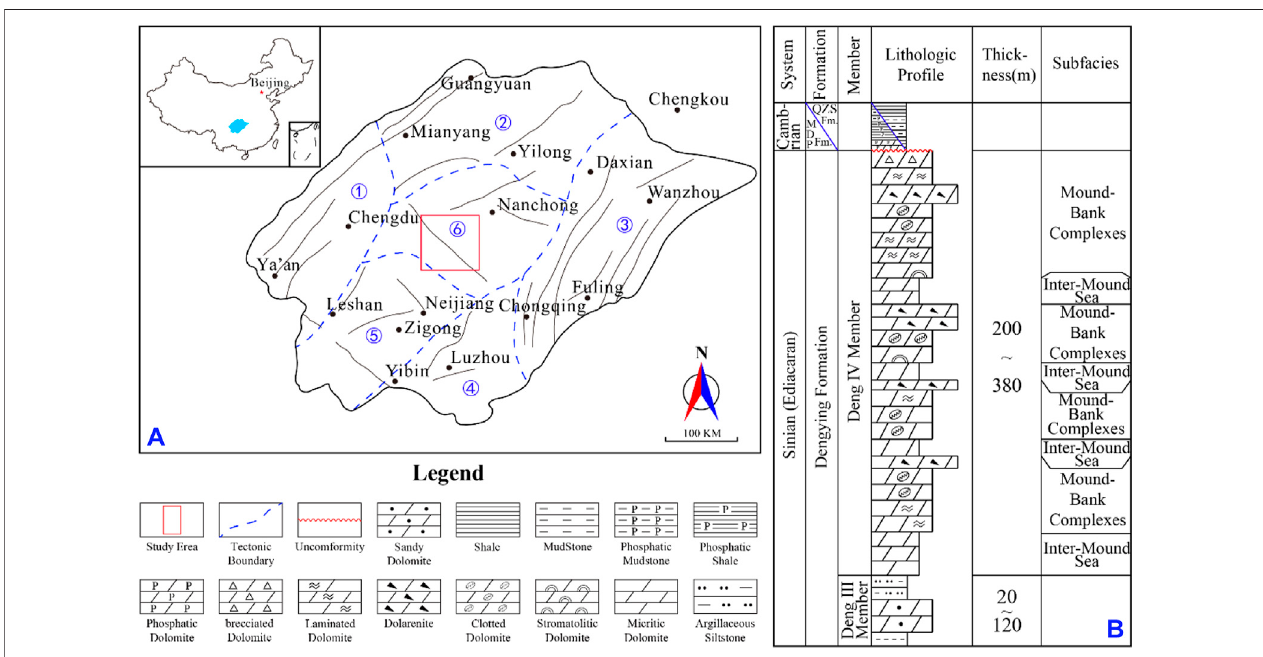
FIGURE 1 | (A) structural map of the Sichuan Basin and the position of the study area. (B) comprehensive stratigraphic section of the Z 2 dn 4 in the GMA.